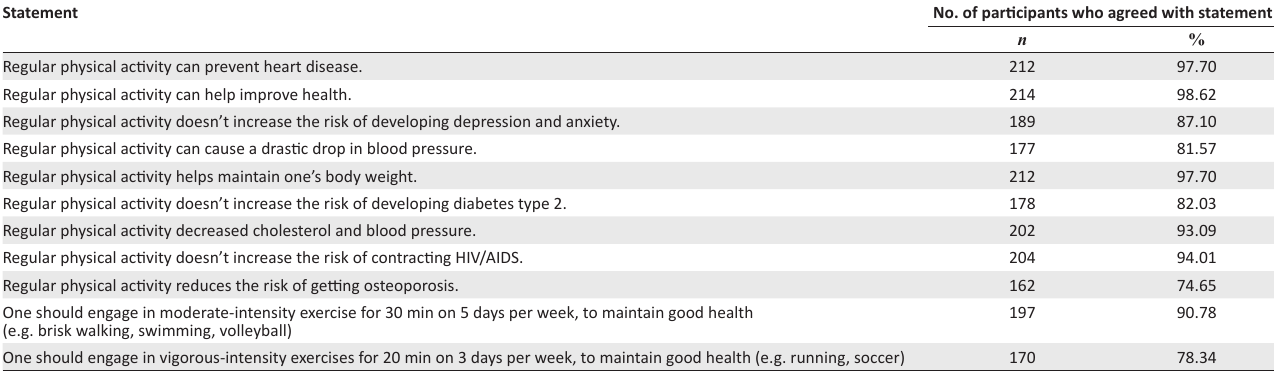
TABLE 3: Participants’ knowledge of physical activity. † Statement No. of participants who agreed with statement